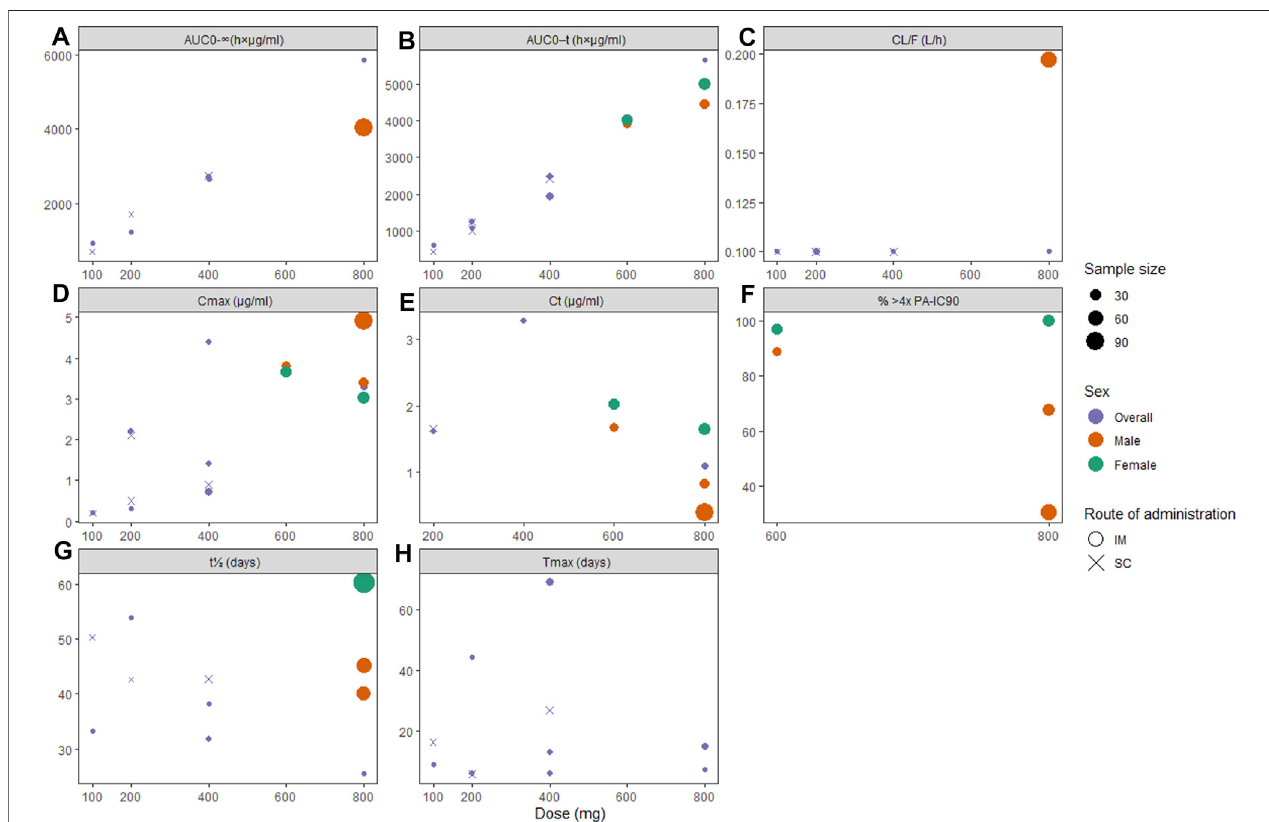
FIGURE 3 | Pharmacokinetic pro fi les of long-acting cabotegravir following the fi nal injection: (A) area under the curve (AUC) from administration time to τ time (AUC 0- τ ), (B) AUC from administration time to in fi nity (AUC 0- ꝏ ), (C) apparent clearance (CL/F), (D) peak concentration (C max ), (E) concentration through τ time (C τ ), (F) proportion of patients with plasma drug concentration > 4x PA-IC 90 , (G) apparent half-life (t 1/2 ), and (H) time to peak concentration (T max ). PA-IC 90 , protein-adjusted inhibitory concentration required for 90% viral